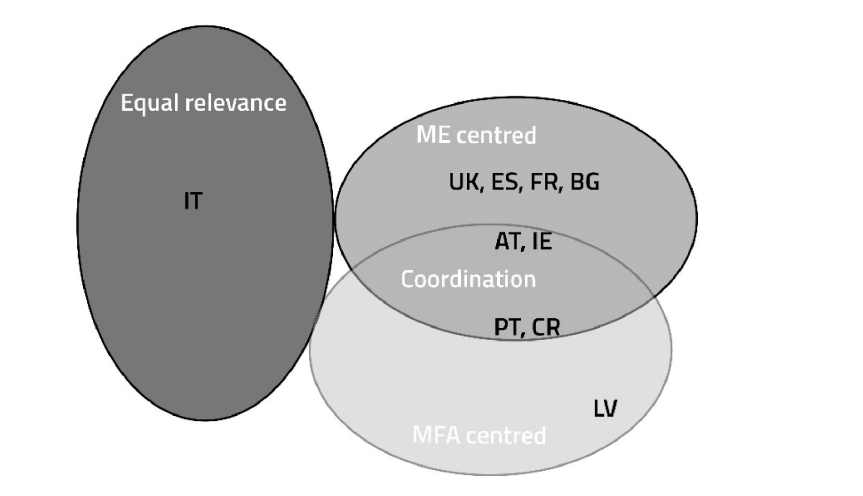
Figure 1: Countries’ ideal types Equal parallel relevance of the two